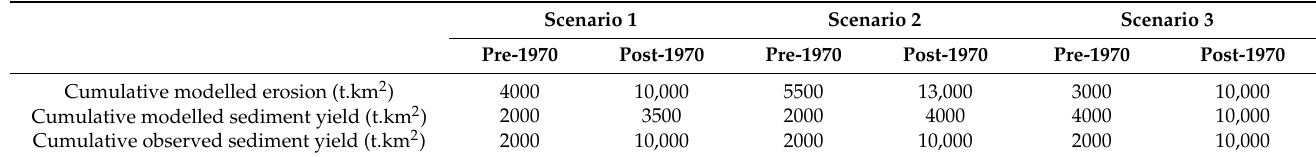
Table 3. Comparison of results for scenario testing in the Cranemere catchment.